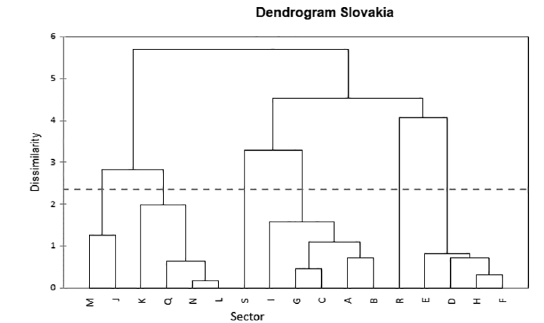
Figure 1. Dendrogram Slovakia (source: